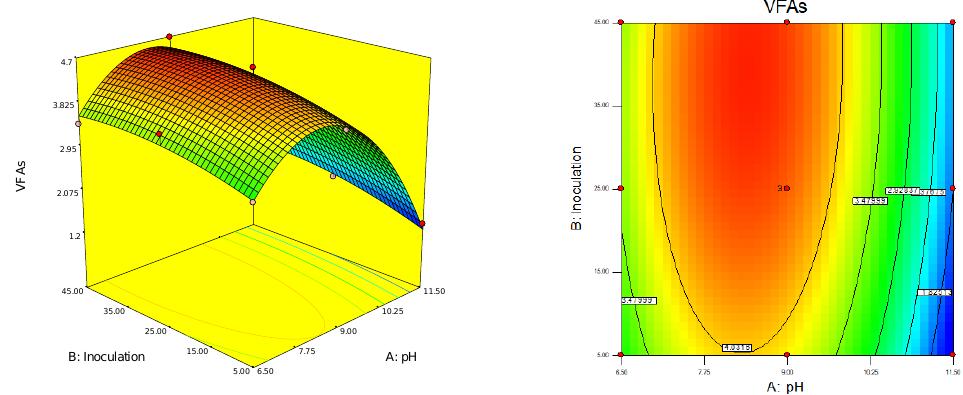
Figure 2. Two- and three-dimensional response surface plots of the quadratic model for VFA con- centrations.